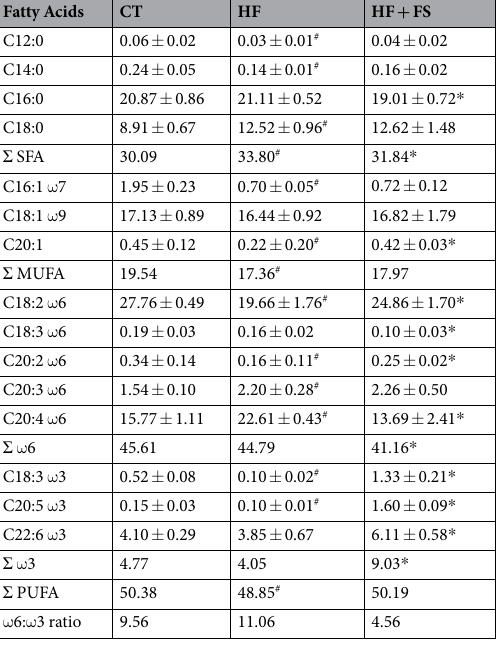
Table 1. Fatty Acids Profile from Blood. CT-Control group; HF-High-fat group; HF + FS-Flaxseed group. SFA-Saturated Fatty Acids; MUFA-Monounsaturated Fatty Acids; PUFA-Polyunsaturated Fatty Acids. Data are present as mean ± standard deviation. N = 5 per group. # vs. CT. * vs. HF group by Bonferroni’s test (P <